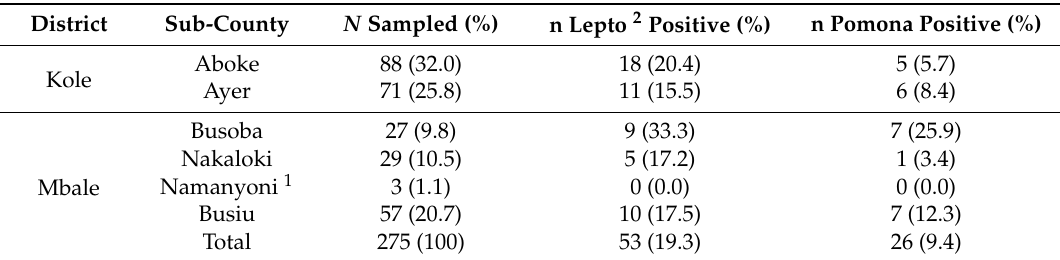
Table 3. Frequency (N) and proportion (%) of sampled cattle by sub-county, and frequency (n) and proportion (%) of Leptospira spp. (“Lepto”) and Pomona seropositive cattle by sub-county of Mbale and Kole districts in